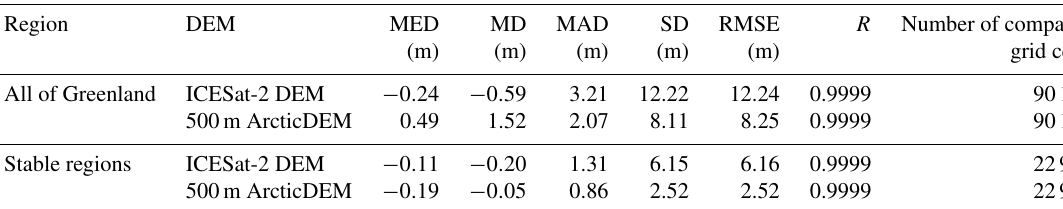
Table 7. Elevation differences of the ICESat-2 DEM and 500m ArcticDEM with respect to IceBridge data in all of Greenland and the stable